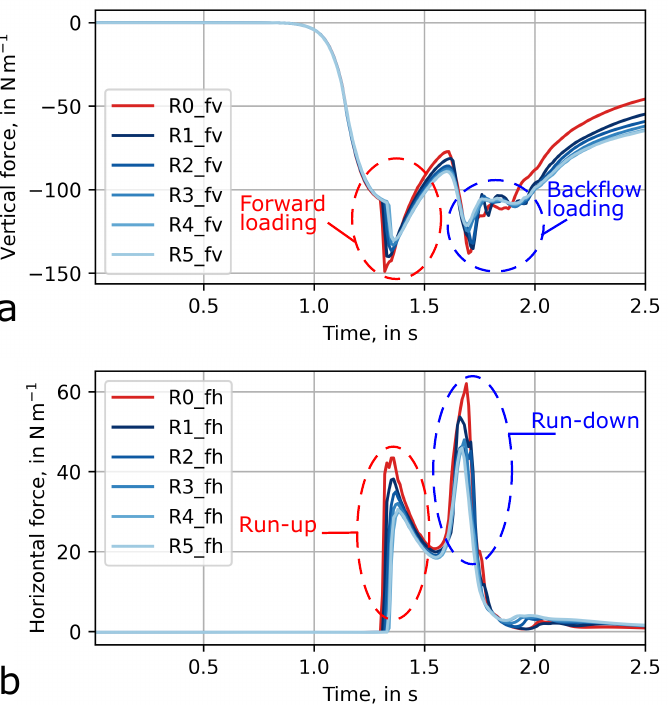
Figure 10. Effect of deck roughness on shipping water loads. ( a ) Time series of vertical loads per unit length over the complete deck ( f v ) for different roughnesses. ( b ) Time series of horizontal loads per unit length on the deck wall ( f h ) for different